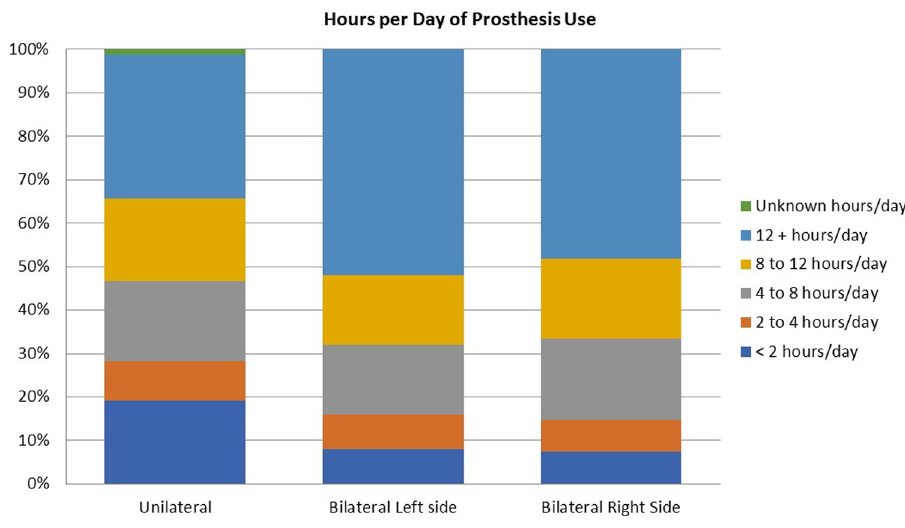
Fig 5. Hours of prosthesis use per